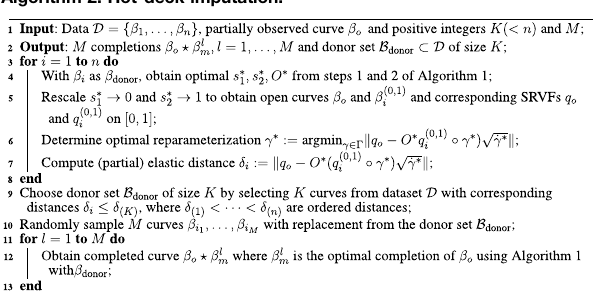
Algorithm 2: Hot-deck